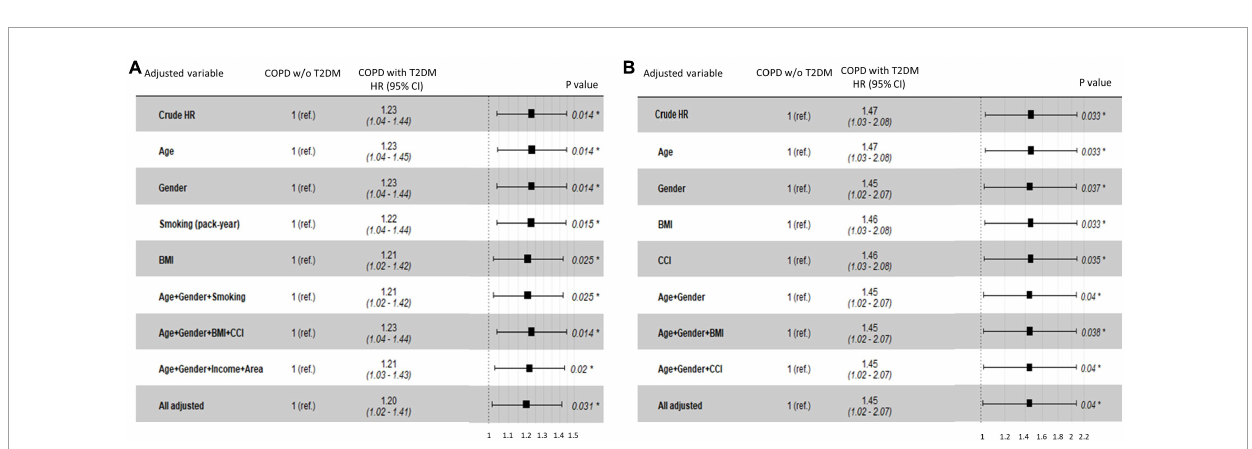
FIGURE3 Hazard ratios for lung cancer risk in COPD patients with T2DM compared with those without T2DM in (A) the NHIS-NSC and (B) the CDM cohort. BMI, body mass index; CCI, Charlson Comorbidity Index; CDM, common data model; NHIS-NSC, national sample cohort of National Health Insurance Service; R. area, residential area; ref., reference; T2DM, type 2 diabetes mellitus; w/o,